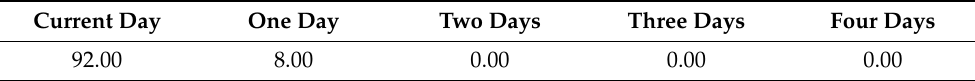
Table 8. Prediction results are based on the average of the differences between R and G in RGB values without noise.